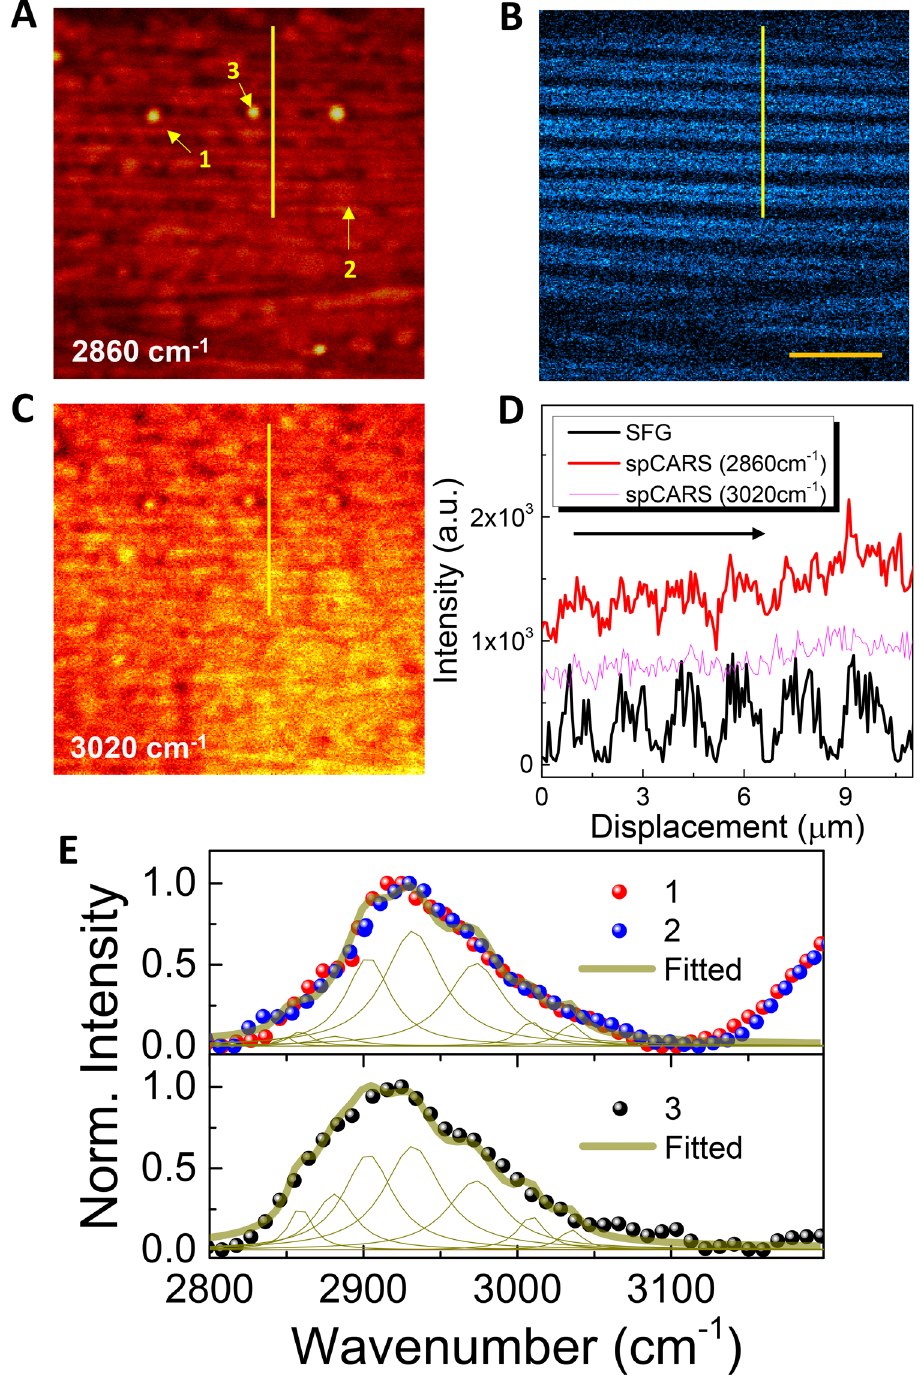
Figure 2. Chemically sensitive identification of muscle subunits. ( A ) The spCARS and (B) SFG images of body-wall muscle near the vulva of WT C. elegans for the 2860 cm − 1 vibration mode; ( C ) spCARS image for 3020 cm − 1 . The scale bar in ( B ) represents 10 μ m. (D) Line profile along the solid line in ( A ) and (B). ( E ) Normalized phase-retrieved spCARS spectra for 1–3 in ( A